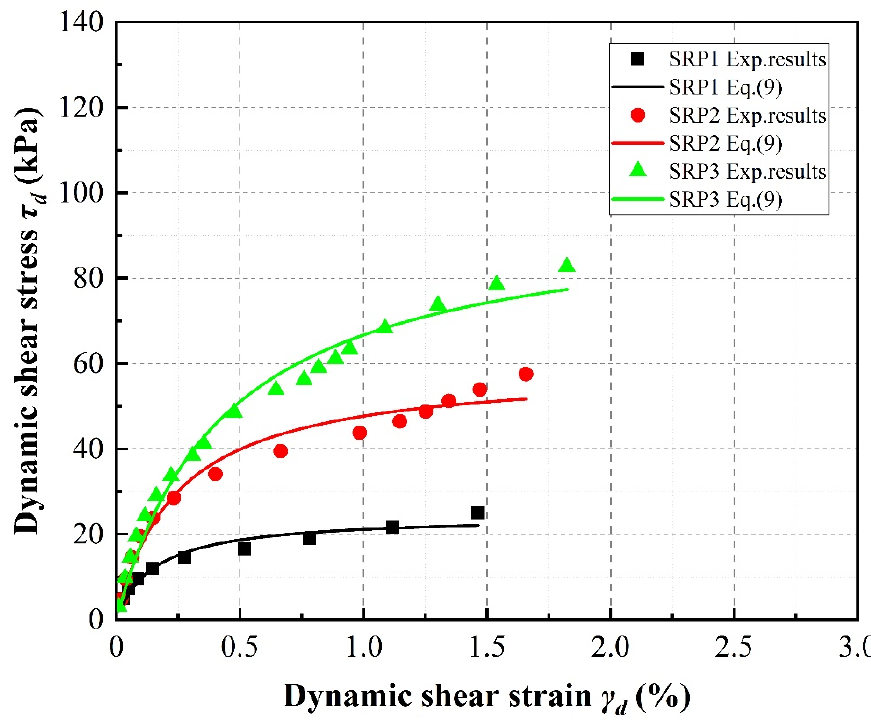
Figure 7. Effect of rubber particle size on stress–strain relationships of sand–rubber mixtures with 20% rubber content under 100 kPa confining pressure. Materials 2020 , 13 , x FOR PEER REVIEW